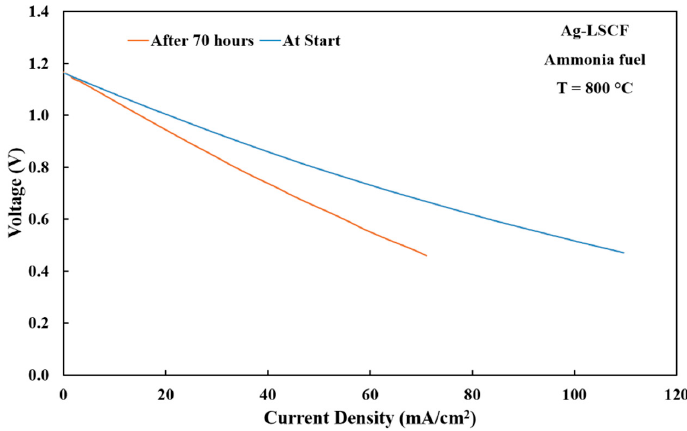
Figure 14. Voltage-current density characteristics of Ag-LSCF//YSZ//GDC/LSCF cell before and after 70 h of operation with ammonia fuel (ammonia = 50 mL/min, air = 75 mL/min) at 800 °C.